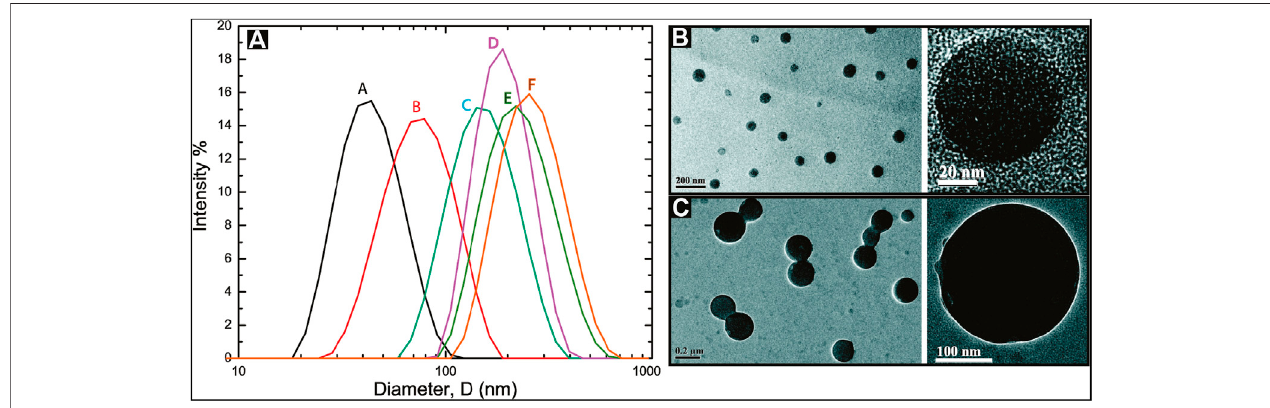
FIGURE 2 | (A) Intensity-weighted particle size distributions for polymeric nanoparticulate drug delivery systems (PNDDS). The mean values of Z-average sizes of differentbatchesofPNDDS were46 ±1 nm (black,A), 81 ±2 nm (red, B), 159± 1 nm (cyan, C), 197± 4 nm (magenta, D), 238± 7 nm (dark yellow,E), and 271±2 nm (orange, F). TEM micrographs for (B) 46 nm PNDDS and (C) 271 nm PNDDS described in a dynamic light scattering (DLS) study (Zhang and Akbulut, 2011).